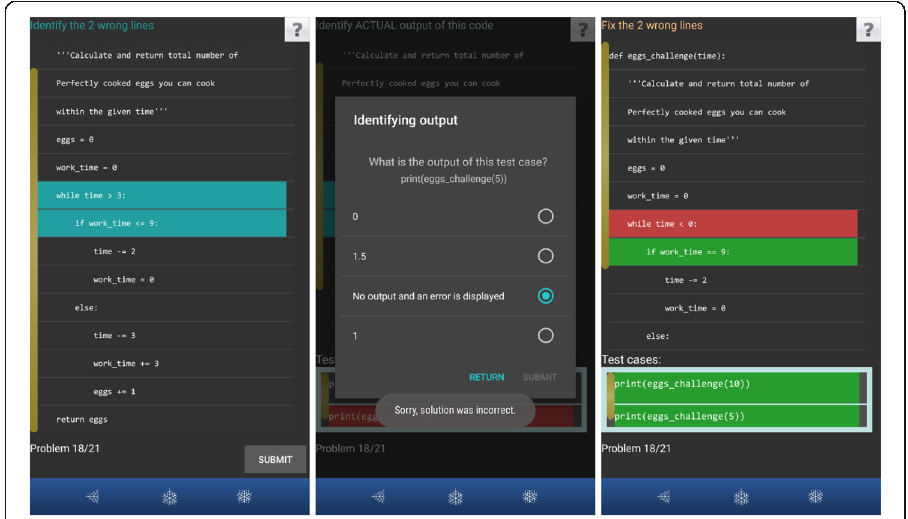
Fig. 2 Example of Dbg_Ident – > Out_Act – > Dbg_Fix activities in PyKinetic_DbgOut (left: Dbg_Ident; middle: Out_Act; right: